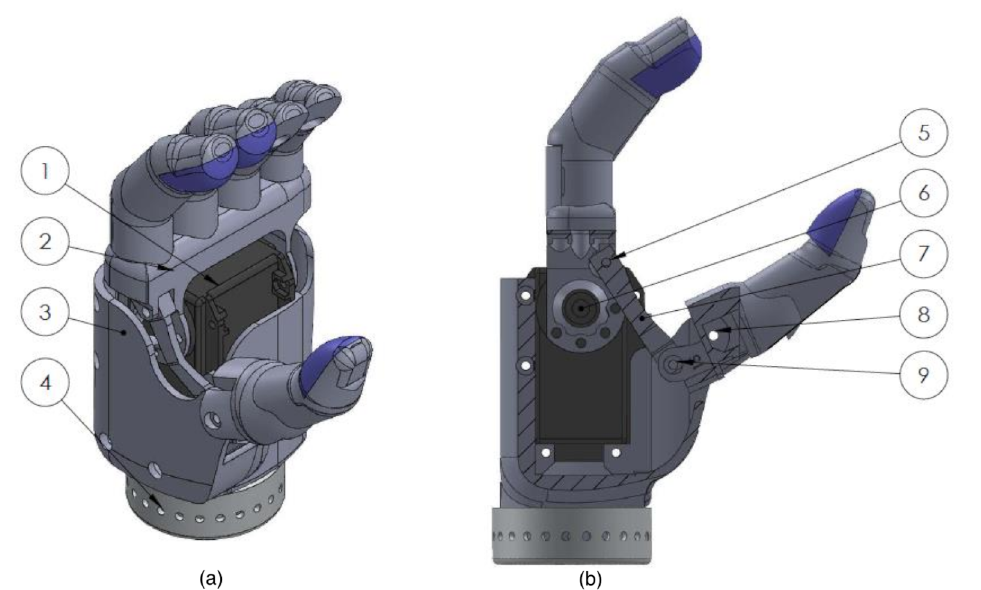
Figure 5. ( a ) Isometric view of the 3D-printed sensorized prosthetic hand. ( b ) Cutaway view of linked bar mechanism. (1) Dynamixel MX-64AT, (2) rigid finger brace, (3) hand casing, (4) wrist adapter, (5) linked bar finger rotation point (6) dynamixel rotation point, (7) linked bar mechanism (8) fixed thumb rotation point (9) linked bar thumb rotation